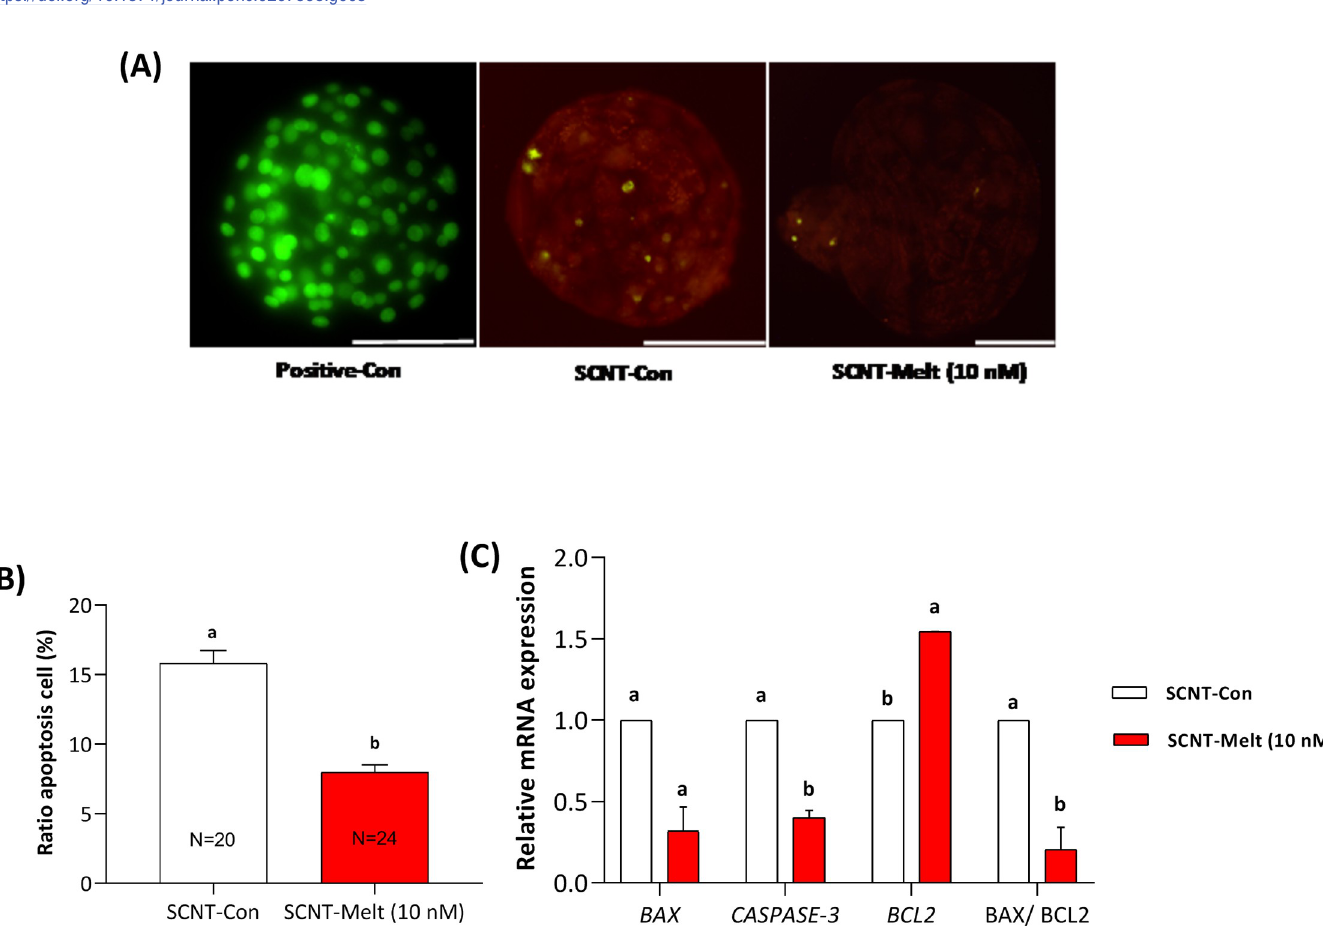
PLOS ONE | https://doi.org/10.1371/journal.pone.0267598 July 21,